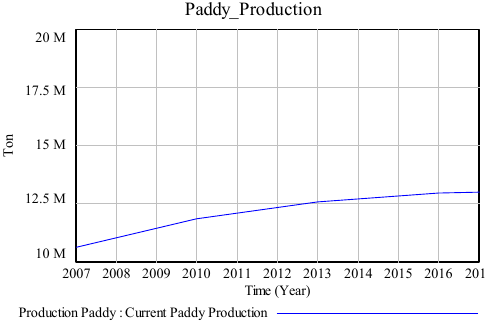
Fig.3 Result of paddy production simulation projection (Year: